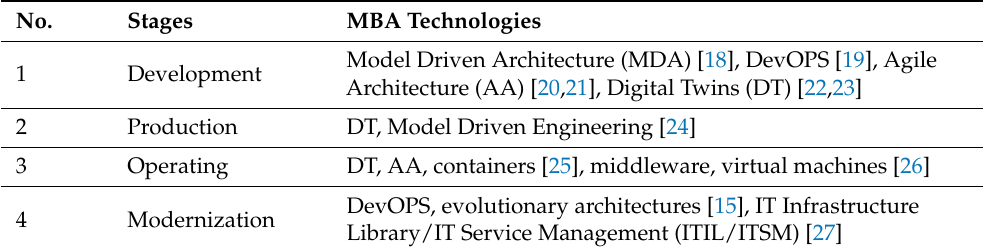
Table 1. The use of MBA technologies at different stages of SwIS